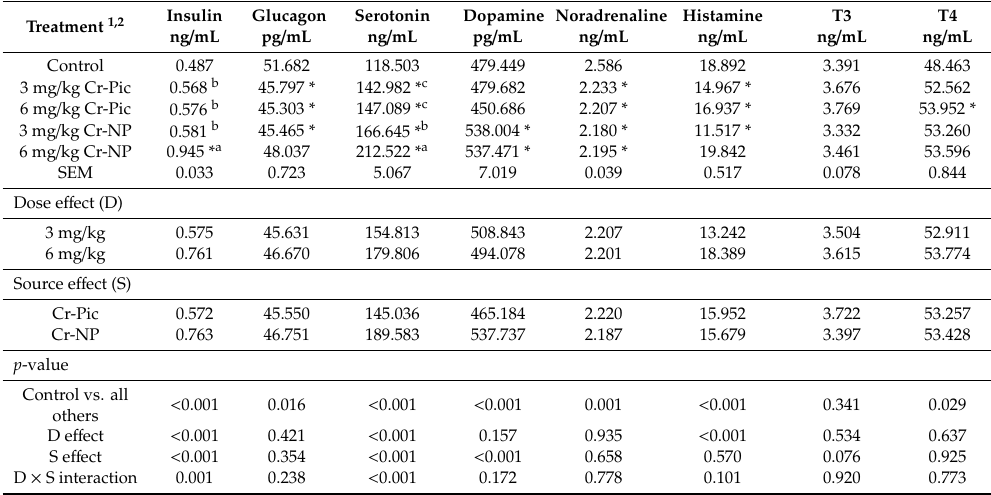
Table 2. Content of hormones in the blood plasma of chickens.